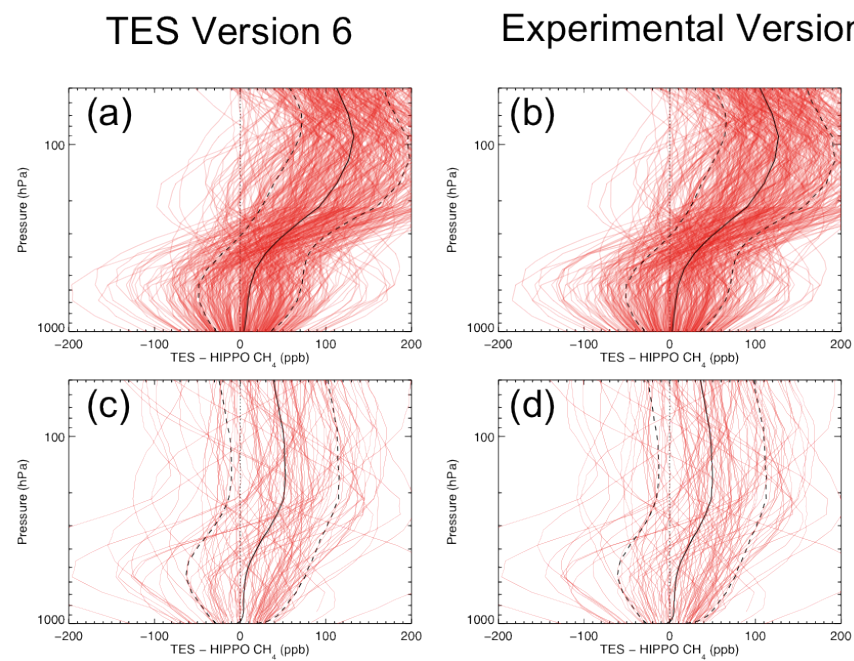
Figure 11. As in Fig. 6, but for the uncorrected CH 4 retrievals from TES Version 6 and the experimental version (see Table 1).